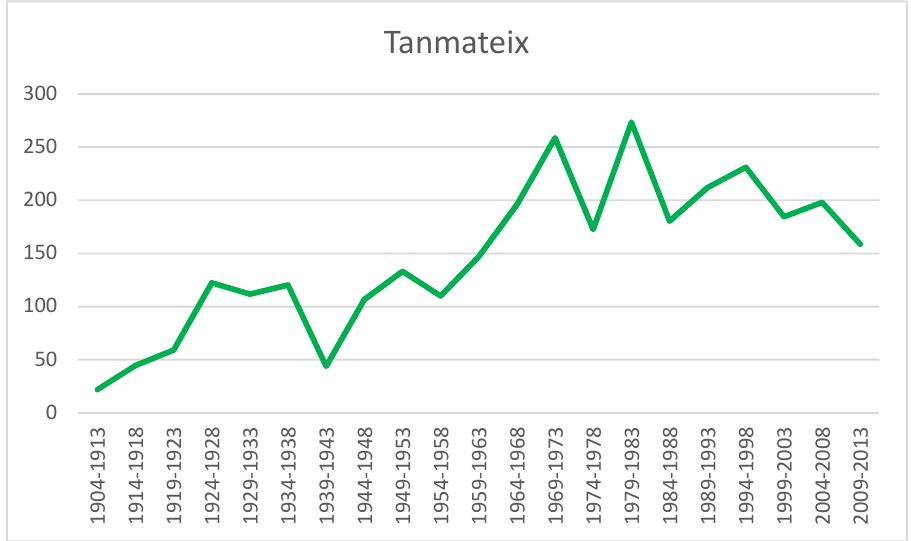
Figure 6. Relative frequency of tanmateix (normalized per 1 million words).